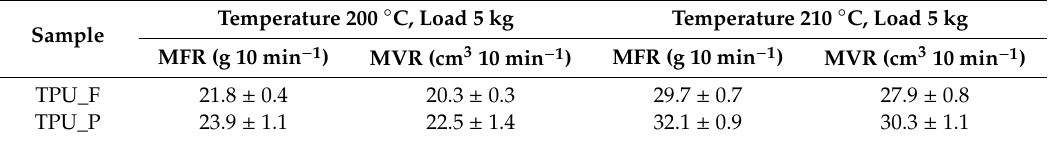
Table 3. The results of melt flow measurements of the TPU filament and printout.